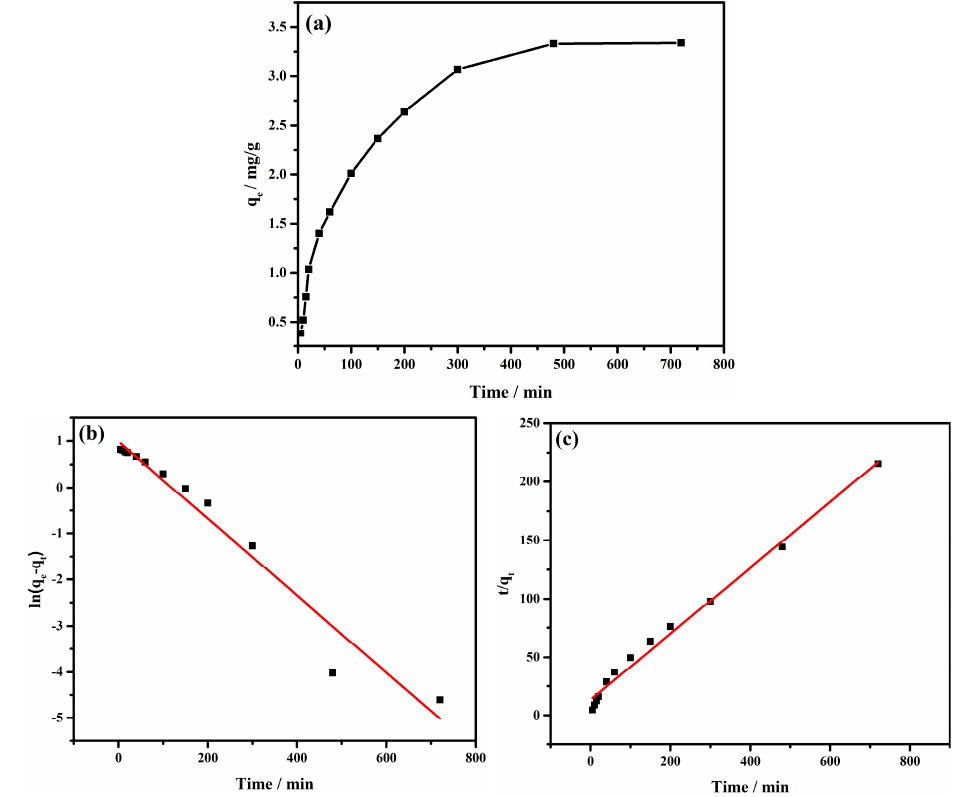
Figure 3. Adsorption kinetics analysis of Cr(VI) on MnFe 2 O 4 adsorbent: ( a ) Adsorption amount of Cr(VI) at various times; ( b ) fitting line of the pseudo − first − order equation; ( c ) fitting line of the pseudo-second-order equation. Table 1. Kinetic fitting parameters for the pseudo-first-order and pseudo-second-order equations for Cr(VI) adsorption onto the MnFe 2 O 4 adsorbent.